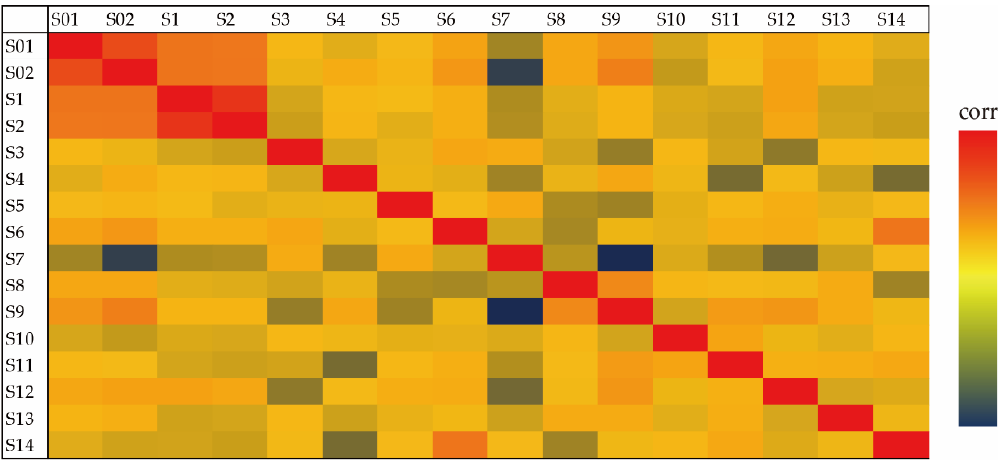
Figure 3. The heatmap of correlation coefficient (corr) matrix among variables. Note: S01–S14 is in the same order as the variable names in Table 1. Darker colors imply larger absolute values of the correlation coefficients among variables. Table 2. Results of ecological agriculture cognition on farmers’ response to specialty orchard fruit